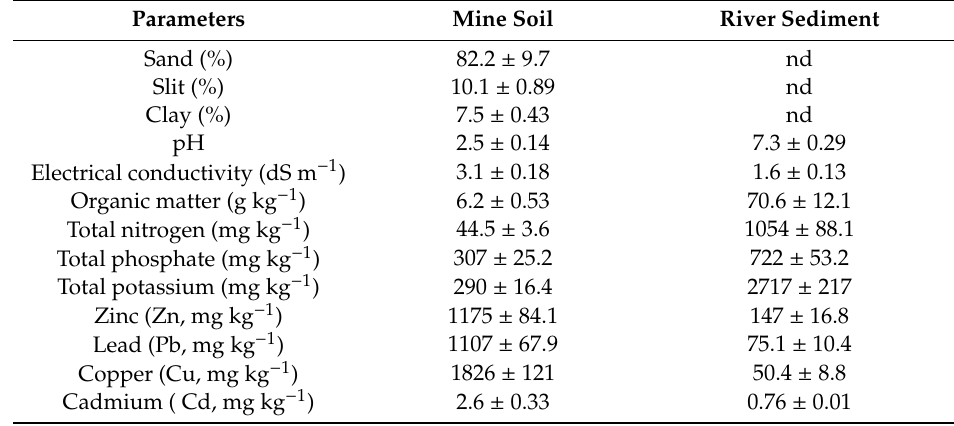
Table 1. Selected physico-chemical properties of the mine soil and river sediment used in the pot experiment.